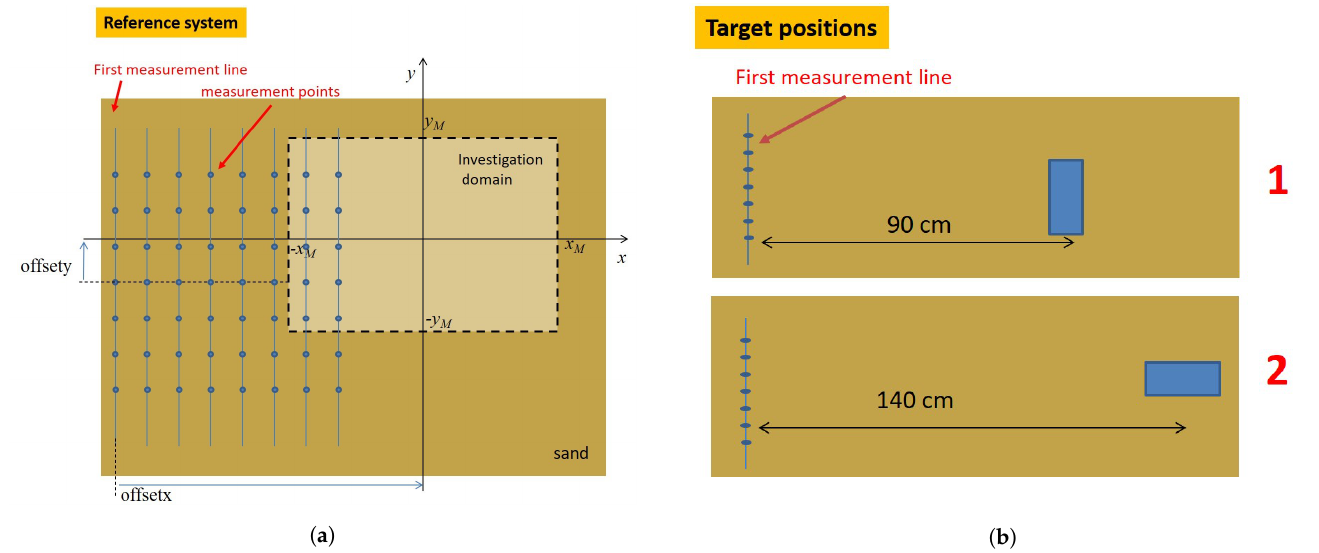
Figure 3. ( a ) Investigation domain and measurement points; the reference system is centred on the investigation domain. ( b ) Different positions of the target with respect to the first (numbered from the left) measurement